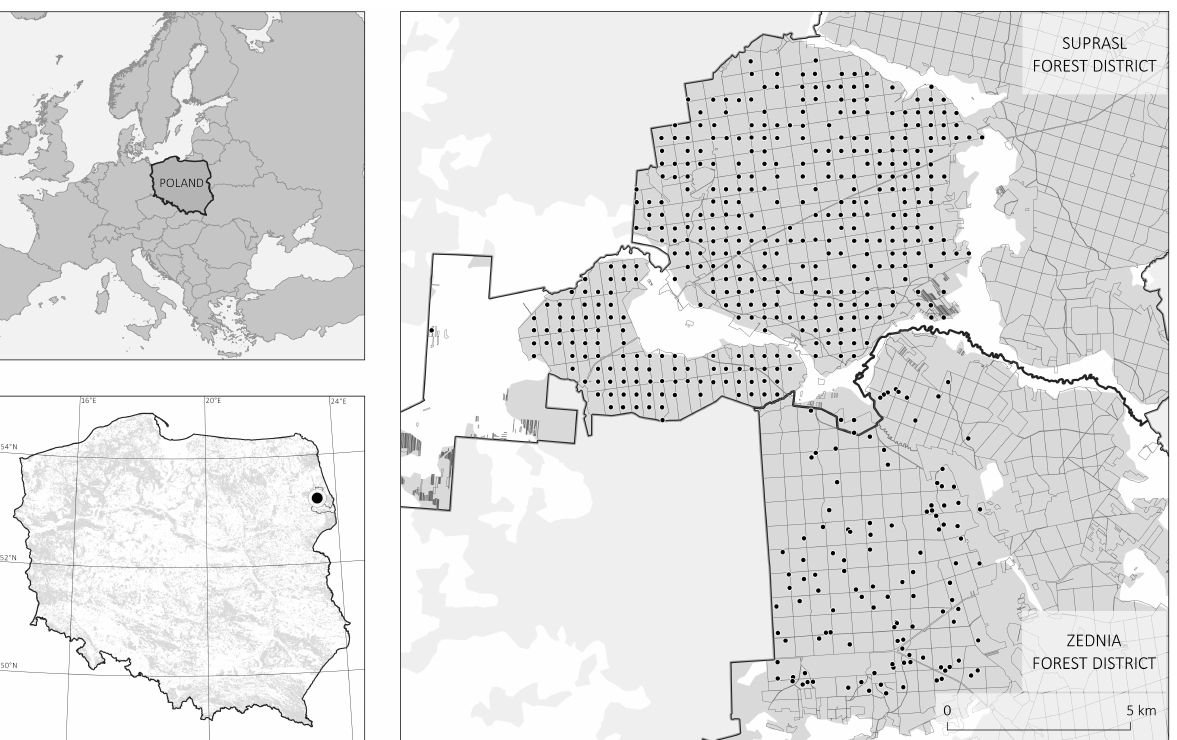
Figure 1. The study area is located in Northeastern Poland (the bottom left map of Poland with the distribution of forested areas in grey). The ground sample plots are distributed across the ˙Zednia Forest District and Supra´sl Forest District (the map on the